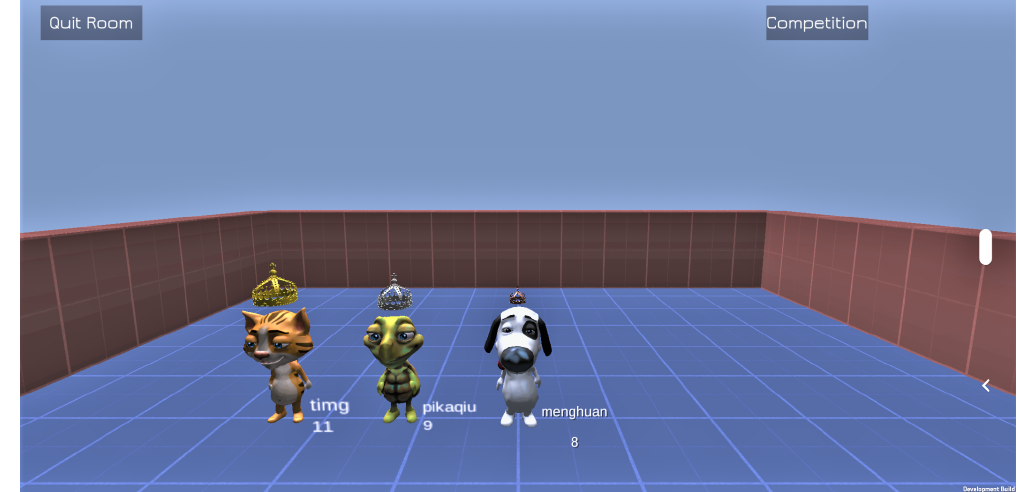
Figure 4. Competitive interaction interface. The pet with highest level will wear a gold crown, while the pet with the second highest level will have a silver crown, and pet with the third highest level will have a bronze